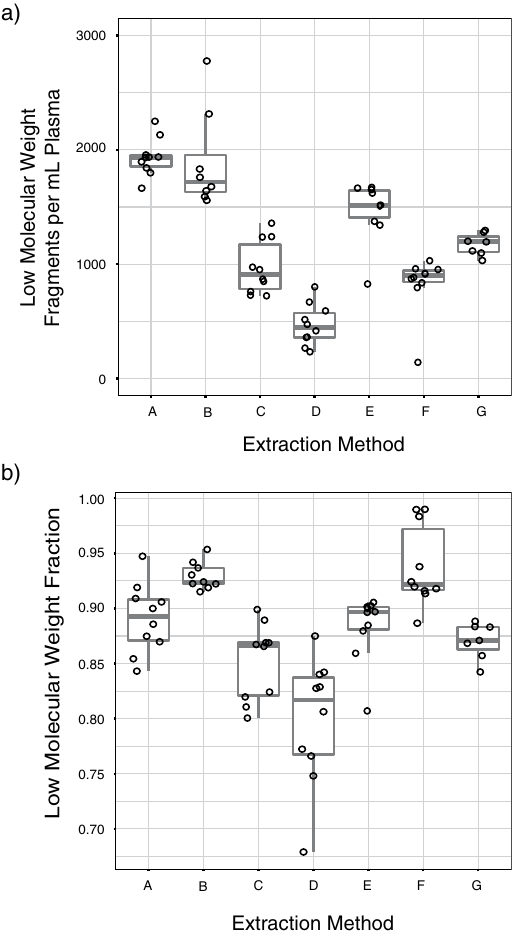
Figure 3. Evaluation of cfDNA extraction methods using ddPCR. Kits labeled A-C use spin columns and kits labeled D-G use magnetic beads for cfDNA isolation. For each extraction kit, n = 10 individual extractions were performed successfully, starting with 1 mL plasma volume except for kit B (n = 9) and kit G (n = 7). Aliquots from a single pool of 250 mL commercially obtained control plasma sample were used for these experiments. ( a ) Comparison of cfDNA yield (in LMW fragments/mL of plasma) across 7 extraction kits. An outlier at 5,306 LMW fragments/mL for Kit B is not shown to enhance scaling. Concentration of LMW fragments in DNA samples was calculated as the difference between average short and long GEs (as shown in Fig. 1). To calculate concentration in input plasma samples, the LMW fragment concentration in DNA samples was multiplied by elution volume and divided by input volume of plasma used during DNA extraction (1 mL). ( b ) Comparison of LMW fraction across 7 extraction kits. LMW fraction was calculated as LMW fragment concentration (difference between average short and long GEs) as a fraction of average short GEs. These data are also listed in Supplemental Table